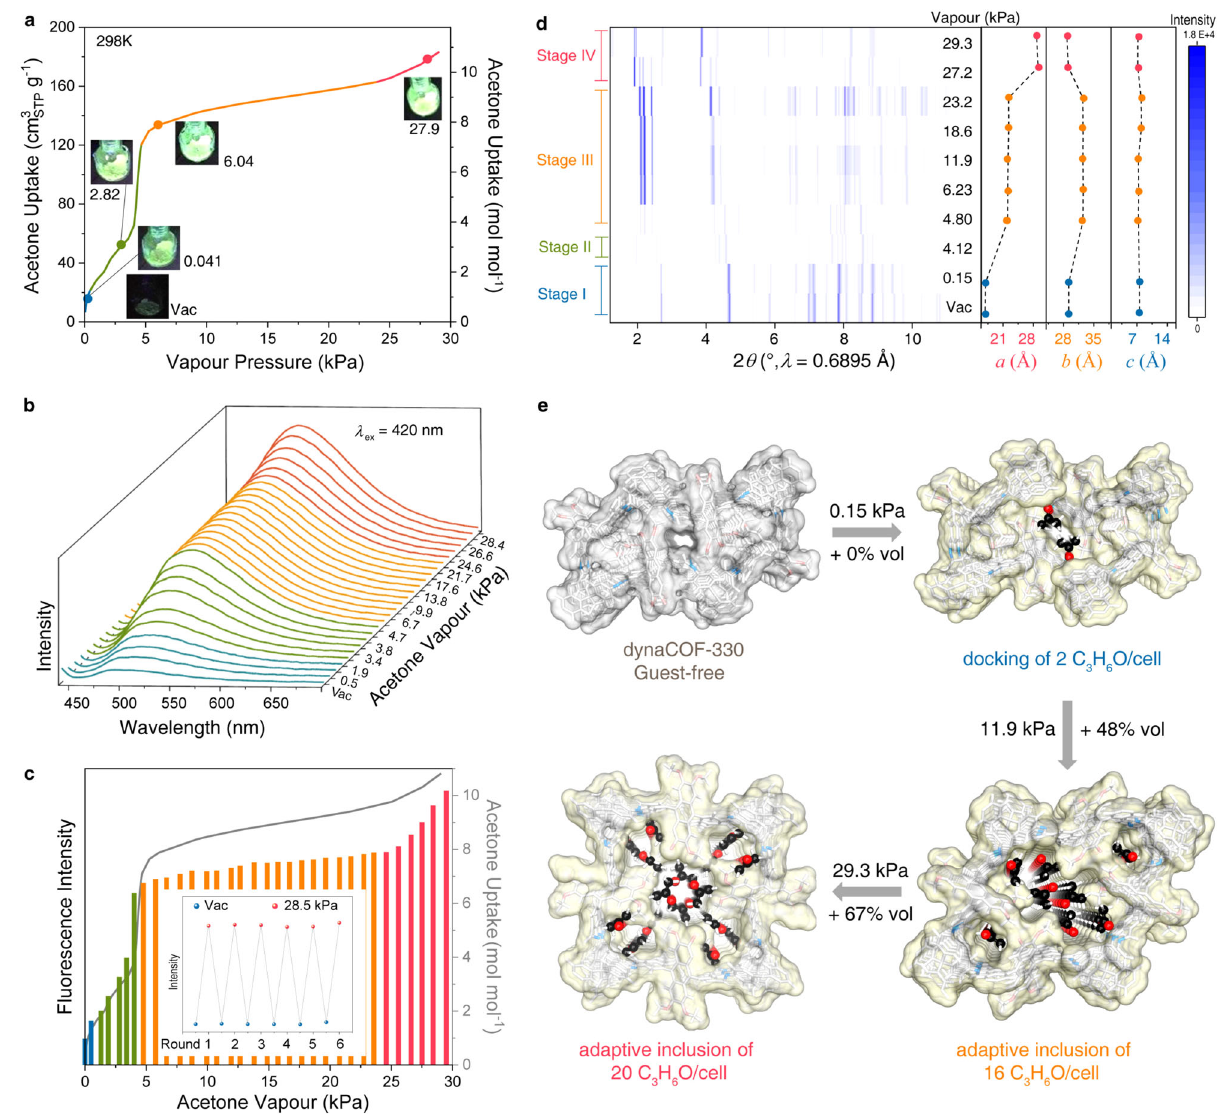
Fig. 3 | Proportional fl uorescence response and structural transition of dyanCOF-330 upon docking and adaptive inclusion of acetone vapour. a OpticalimagesofdynaCOF-330under365-nmUVlightsshowingthe fl uorescence turn-onandcolourchangeforrepresentativeequilibriumpressuresanduptakesof acetone vapour at 298K. b Quantitative in-situ fl uorescence spectroscopy of dynaCOF-330 showing maxima redshift of emission wavelength. c Correlation of fl uorescence emission intensity with acetone vapour uptake with an inset for the